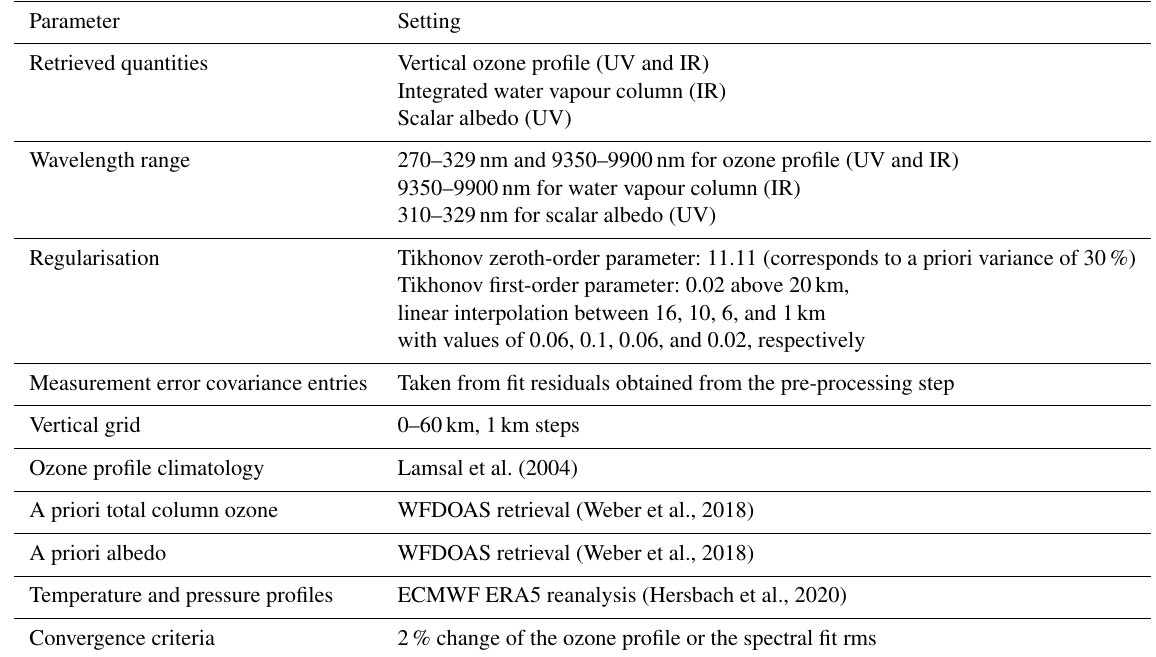
Table 1. Settings of the TOPAS retrieval step.